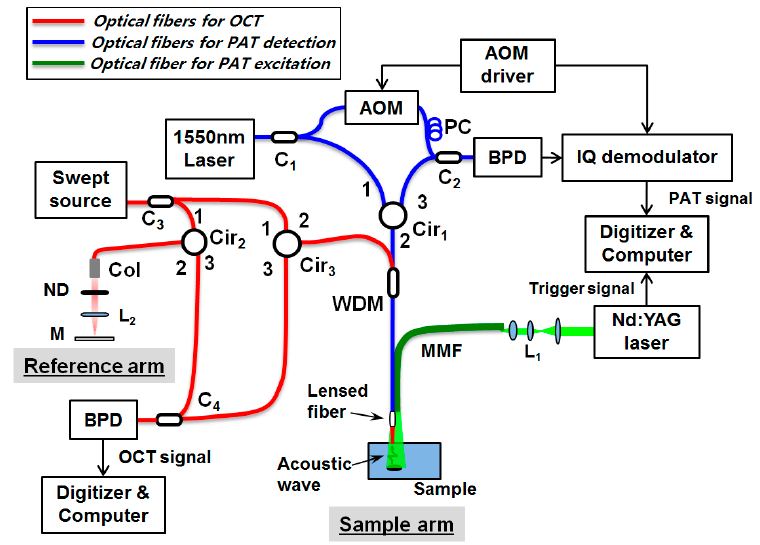
Figure 1. Schematic of the all-fiber-based dual modality of photoacoustic and optical coherence tomography with a miniature common probe. AOM: acousto-optic modulator; PC: polarization controller; BPD: balanced photodetector; C 1 –C4: fiber coupler; Cir 1 –Cir 3 : fiber circulator; Col: